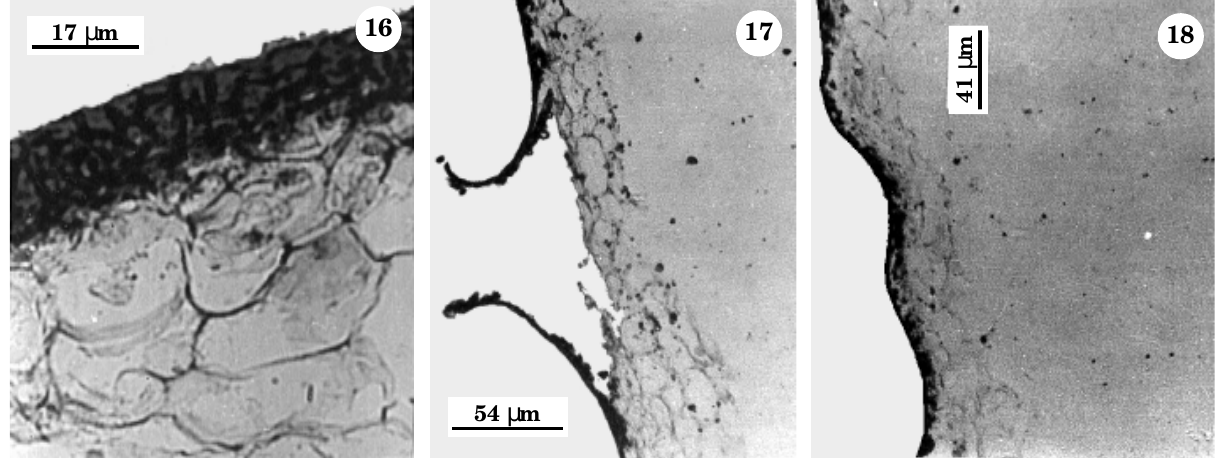
Fig. 16-18. Cross sections of pericarp of Marmande tomato fruit infected with TMV-M showing the epidermal layers very thick and covered also with thick cuticle layer (16), rupture of epidermis (17), undulation of epidermis